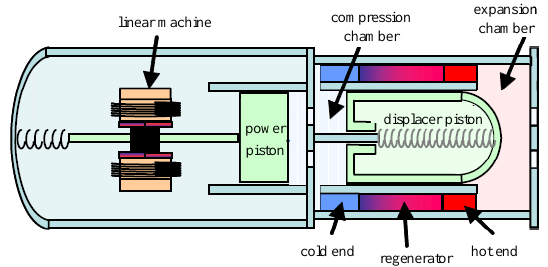
Figure 1. Structural schematic diagram of free-piston Stirling power generating system.